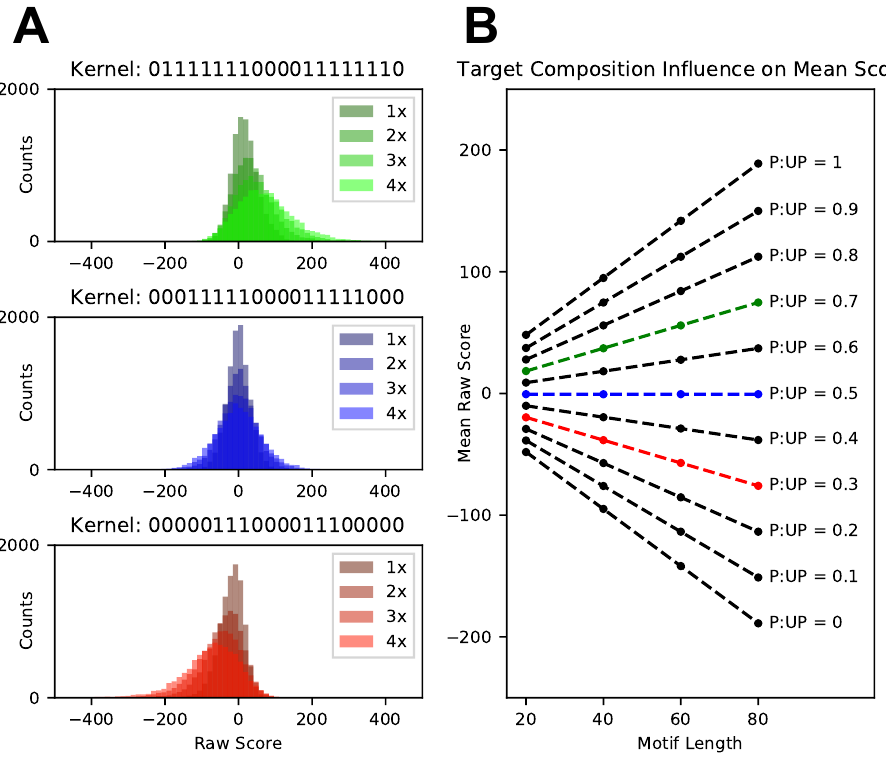
Figure 1. Distributions of raw scores associated with three target motif kernels. ( A ) Raw score distributions for three motif kernels of equal length and composed of 70% paired (top), balanced (middle), and 30% paired nucleotides (bottom). Overlaid are distributions for longer motifs obtained by concatenating kernels two (2 × ), three (3 × ), and four times (4 × ). ( B ) Mean raw scores for each of the distributions (red, blue, and green). The x -axis represents motif lengths corresponding to kernels repeated 1 × (20-nt), 2 × (40-nt), 3 × (60-nt) and 4 × (80-nt). Mean raw scores for distributions obtained when searching the Weeks set for additional kernels spanning a range of possible pairing state compositions are denoted in black. Dashed lines indicate a linear regression of the mean scores observed when extending a kernel’s